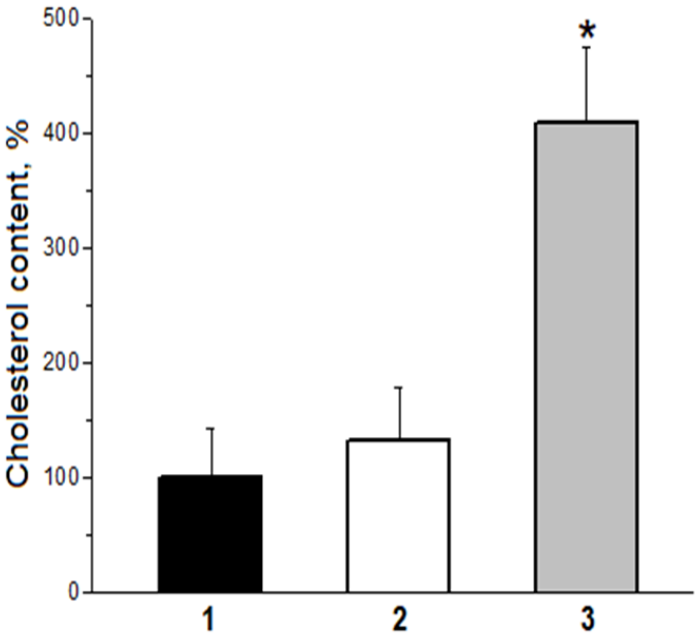
Figure 5. Efficiency of capture by cultured human macrophages of LDL particles modified by pri- primary and secondary products of free radical lipid oxidation. 1—initial native (non-oxidized) LDL; mary and secondary products of free radical lipid oxidation. 1 — initial native (non-oxidized) LDL; 2—LDL oxidized by animal C-15 LOX (true oxidized, LOOH-containing LDL); 3—MDA-modified 2 — LDL oxidized by animal C-15 LOX (true oxidized, LOOH-containing LDL); 3 — MDA-modified LDL (apoB-100—100 µ g/mL; * p < LDL (apoB-100 — 100 µg/mL ; * p < 0.05).